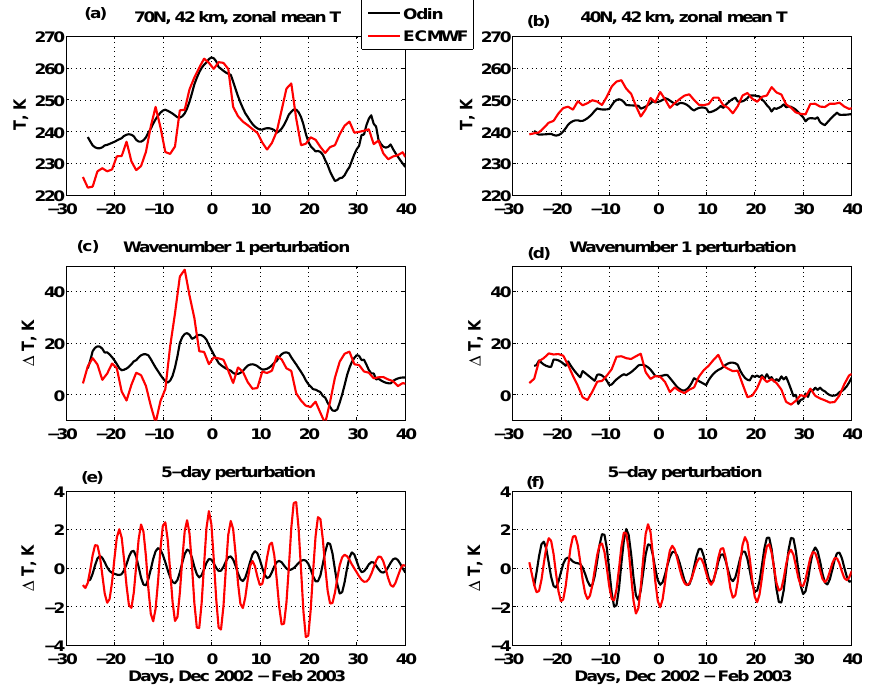
Fig. 10. Zonal means, wavenumber one and 5-day perturbations in temperature at 42km, at 70 ◦ N (left-hand panel) and at 40 ◦ N (right-hand panel) from Odin (black line) and ECMWF (red